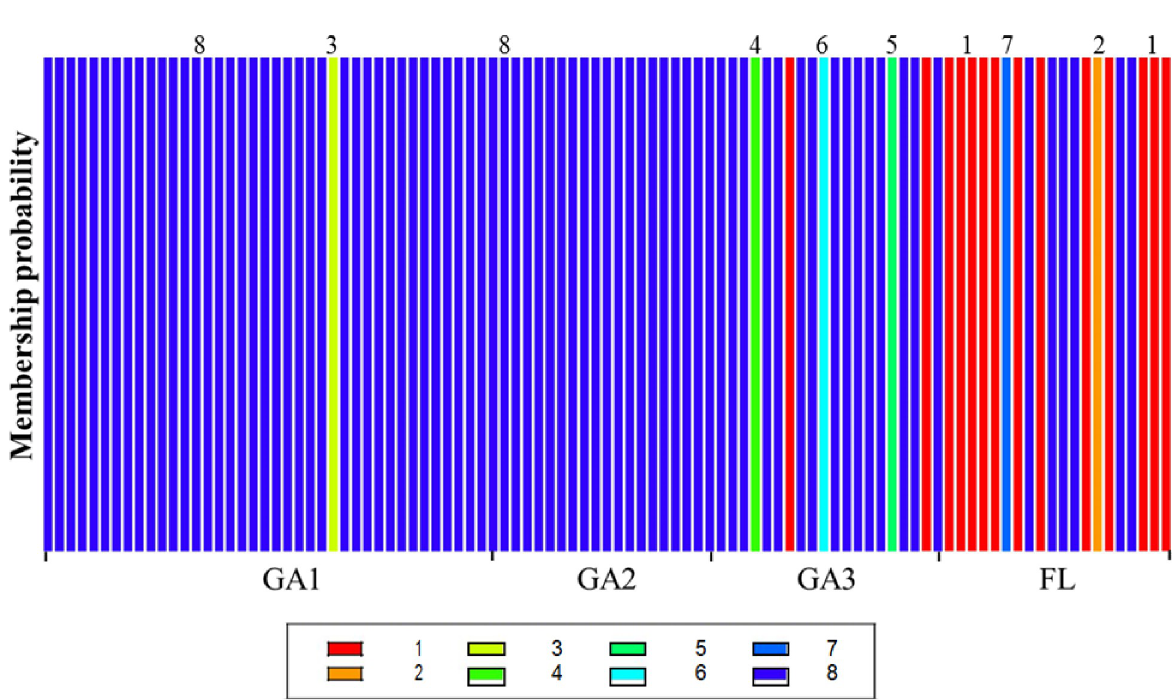
Fig 3. Discriminant analysis of principal components for Fusarium oxysporum f. sp. niveum (FON) from the southeastern United States showing a histogram of assignment probability of 99 FON isolates from 4 field populations into eight genetic clusters. The four populations include: Berrien County, Georgia (GA1), Cook County, Georgia (GA2), Tift County, Georgia (GA3), and Florida